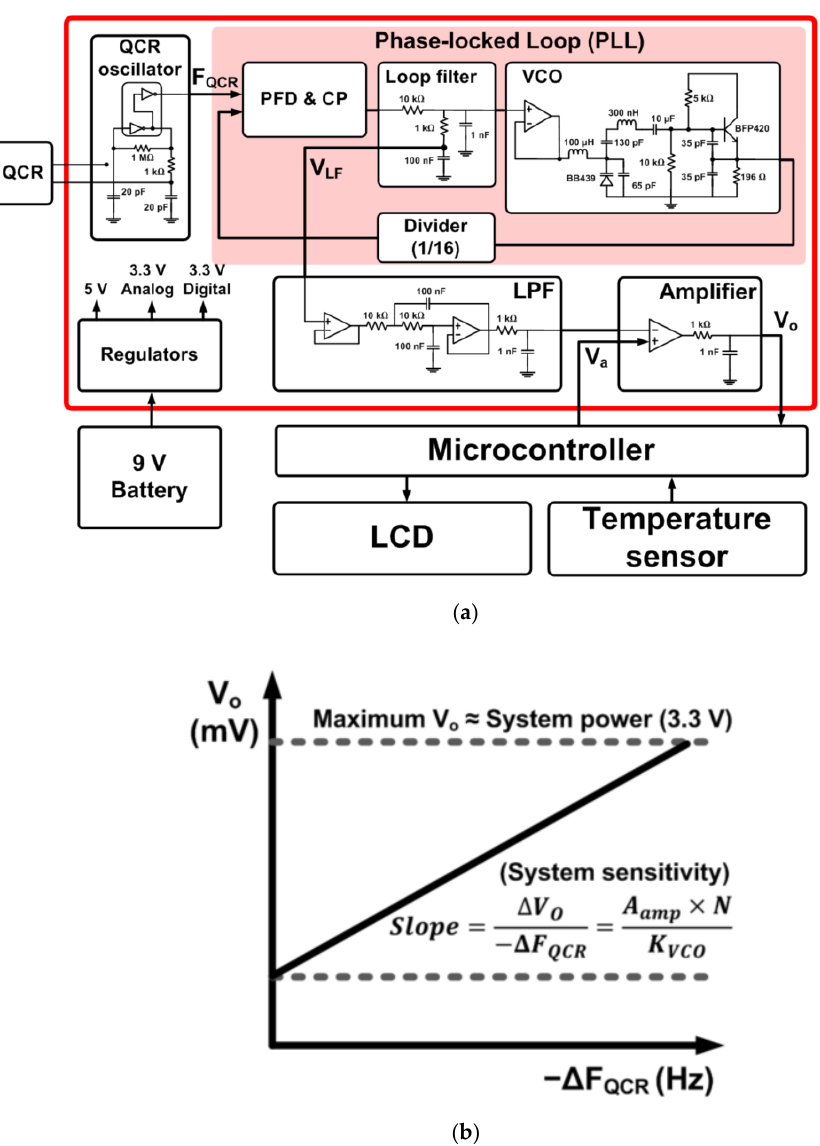
Figure 1. Designed QCM measurement system: ( a ) a block diagram of the PLL-based measurement system and ( b ) system output voltage to input frequency shift.